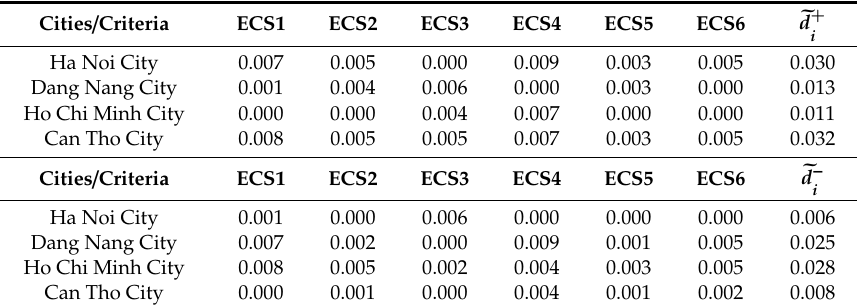
Table 14. Distance of each alternative from FPIS and FNIS.